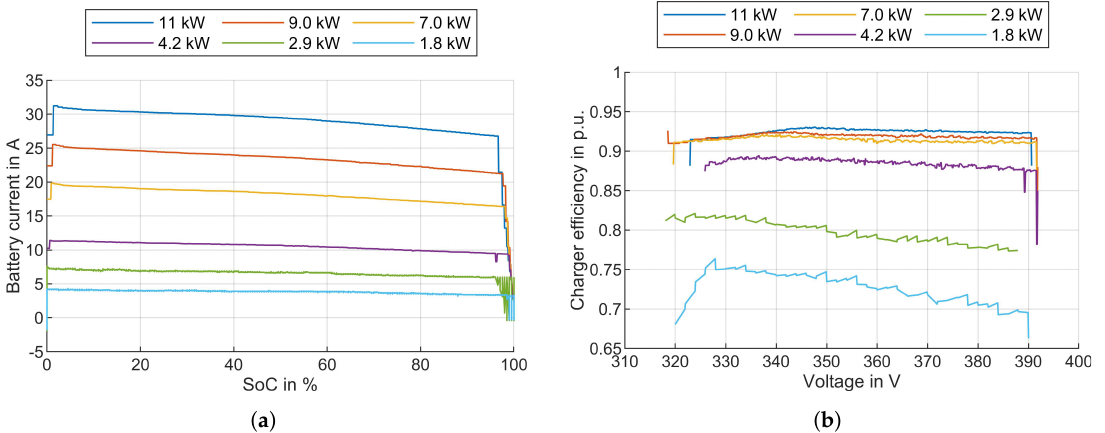
Figure 12. Measurement results of EV charging. ( a ) Charging current (DC) versus SOC using differ- ent charging power settings; ( b ) Charging efficiency versus battery voltage using different charging power